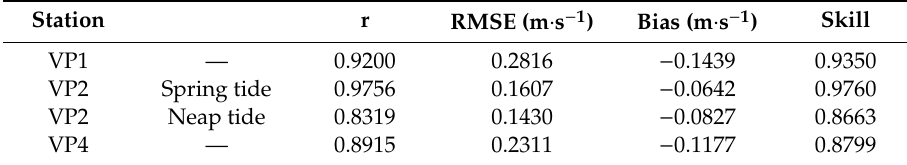
Figure 5. Current velocity (water column averaged) time series at the calibration stations. Field data (black dots) and numerical data (grey line). ( a ) Station VP1; and ( b ) Station VP4. Table 5. Error metrics for the current velocities measured at fixed depth points.